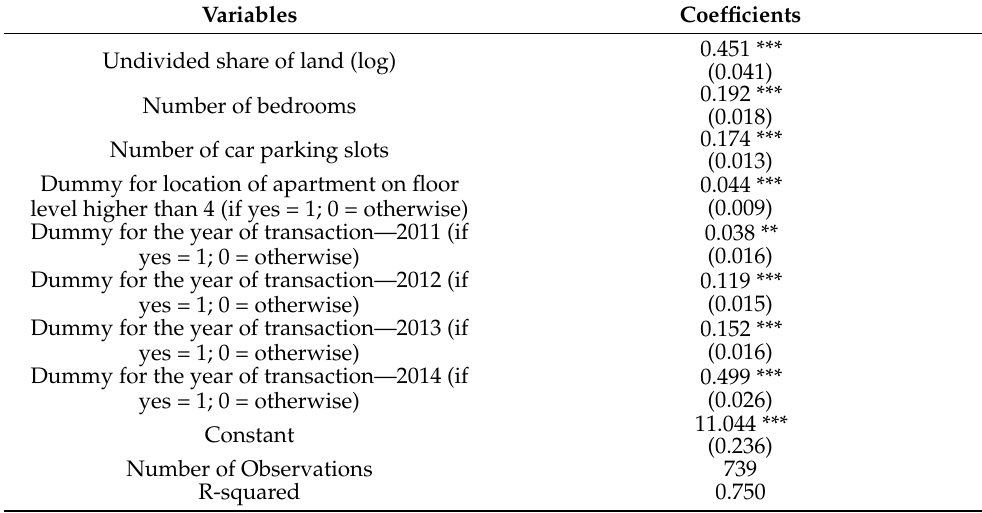
Table 1. Hedonic price model estimation for market value of apartments. Dependent variable: Market value of apartment